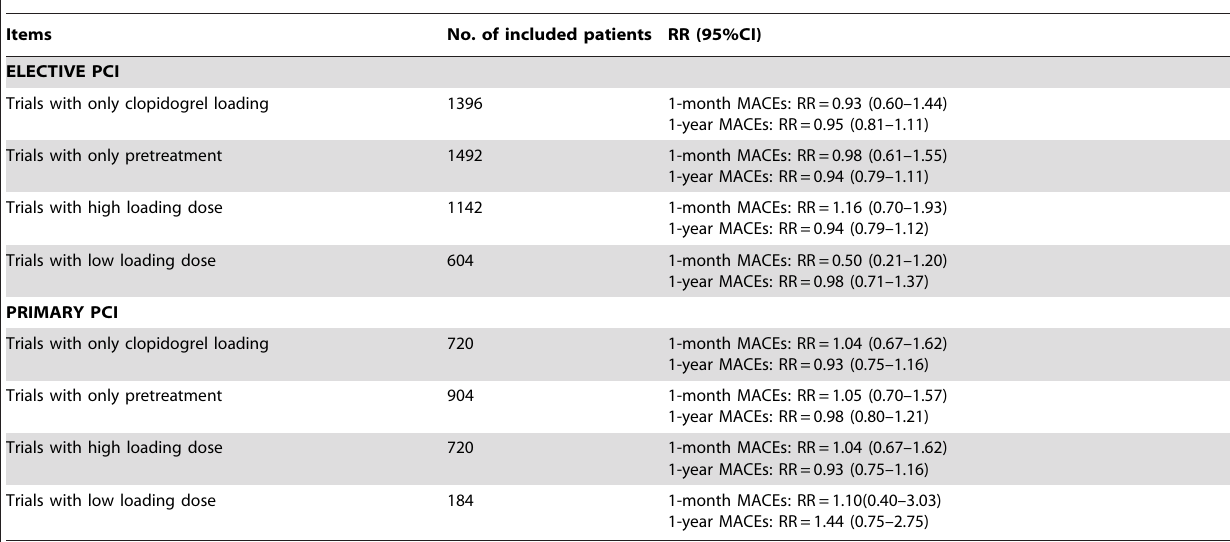
Table 1. Sensitivity analyses for patients with elective and primary